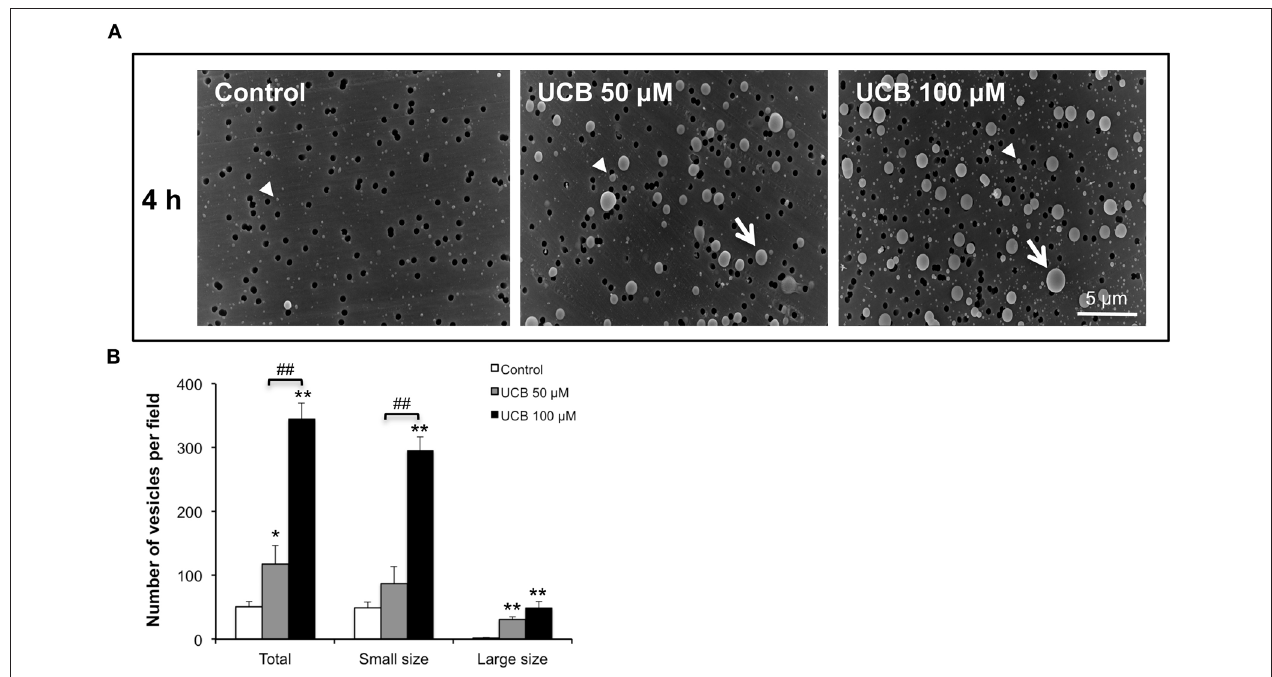
period are shown (A) . Quantification of small (arrowhead), large (arrow) and total number of vesicles is shown (B) and results are means ± SEM from three independent experiments performed in duplicate. ∗ P < 0 . 05 and ∗∗ P < 0 . 01 vs . control. ## P < 0 . 01 UCB 100 vs . 50 μ